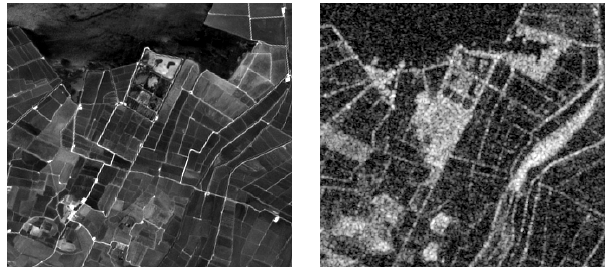
Figure 2. Visual comparison between Sentinel 2, B2 band on the left, and Sentinel 1, VV polarization on the